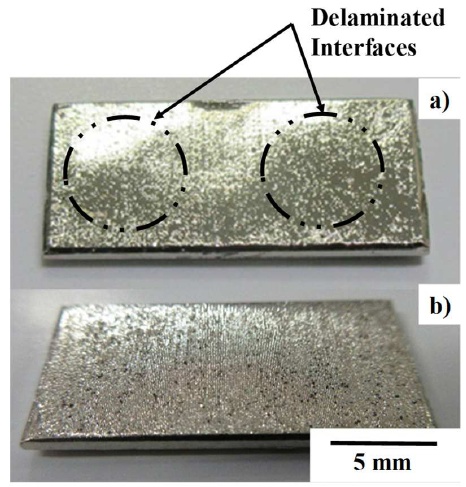
Figure 13. Copper-VGS package specimens after the thermal transient loading test in a single shot.